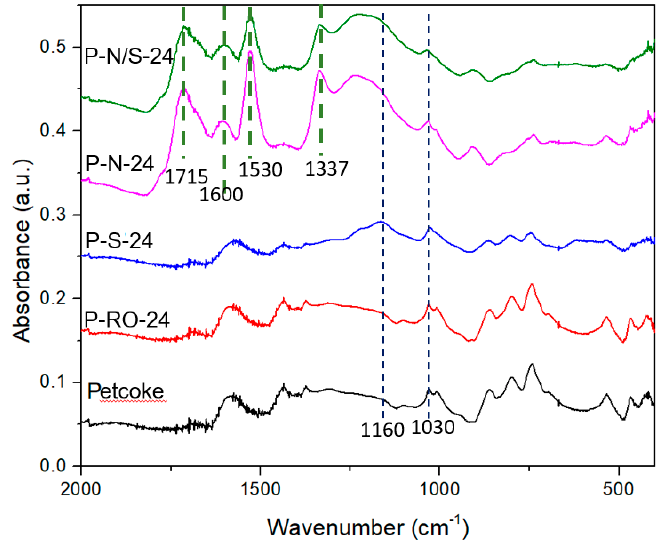
Figure 1. FTIR spectra of petcoke before and after refluxing in different solutions at 120 °C for 24 h.